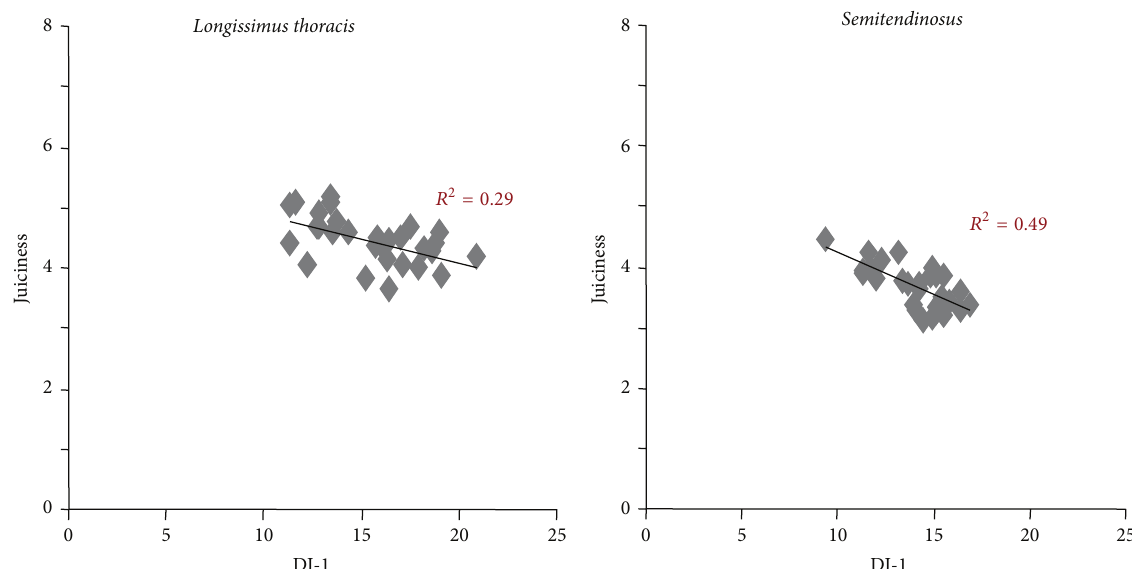
Figure 2: Relationships between the abundance of DJ-1 protein evaluated by dot-blot (arbitrary unit) and the juiciness score estimated by trained panellists on semitendinosus and longissimus thoracis muscles of Salers young